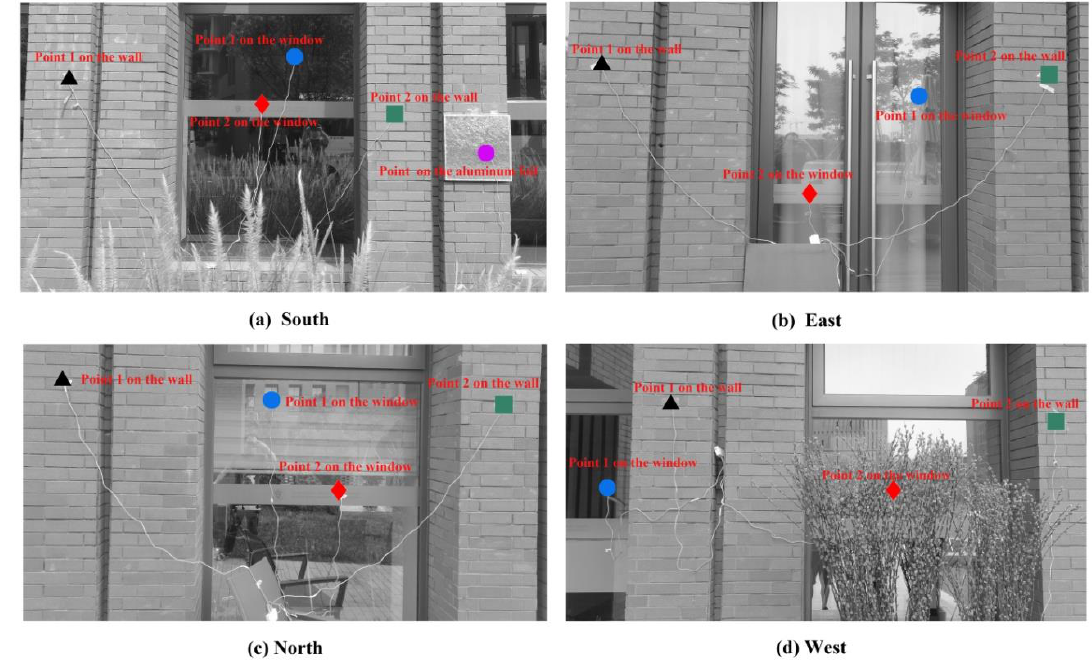
Figure 14. Thermocouple measuring points.